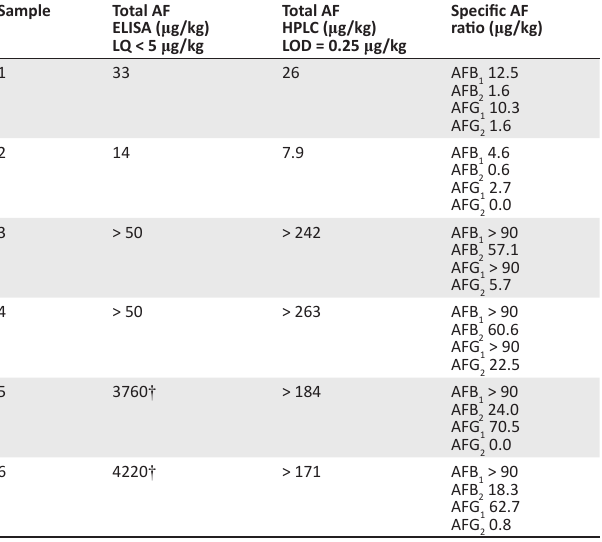
TABLE 1: Aflatoxin concentrations in Hi-PRO ® dog food samples ( n = 6).